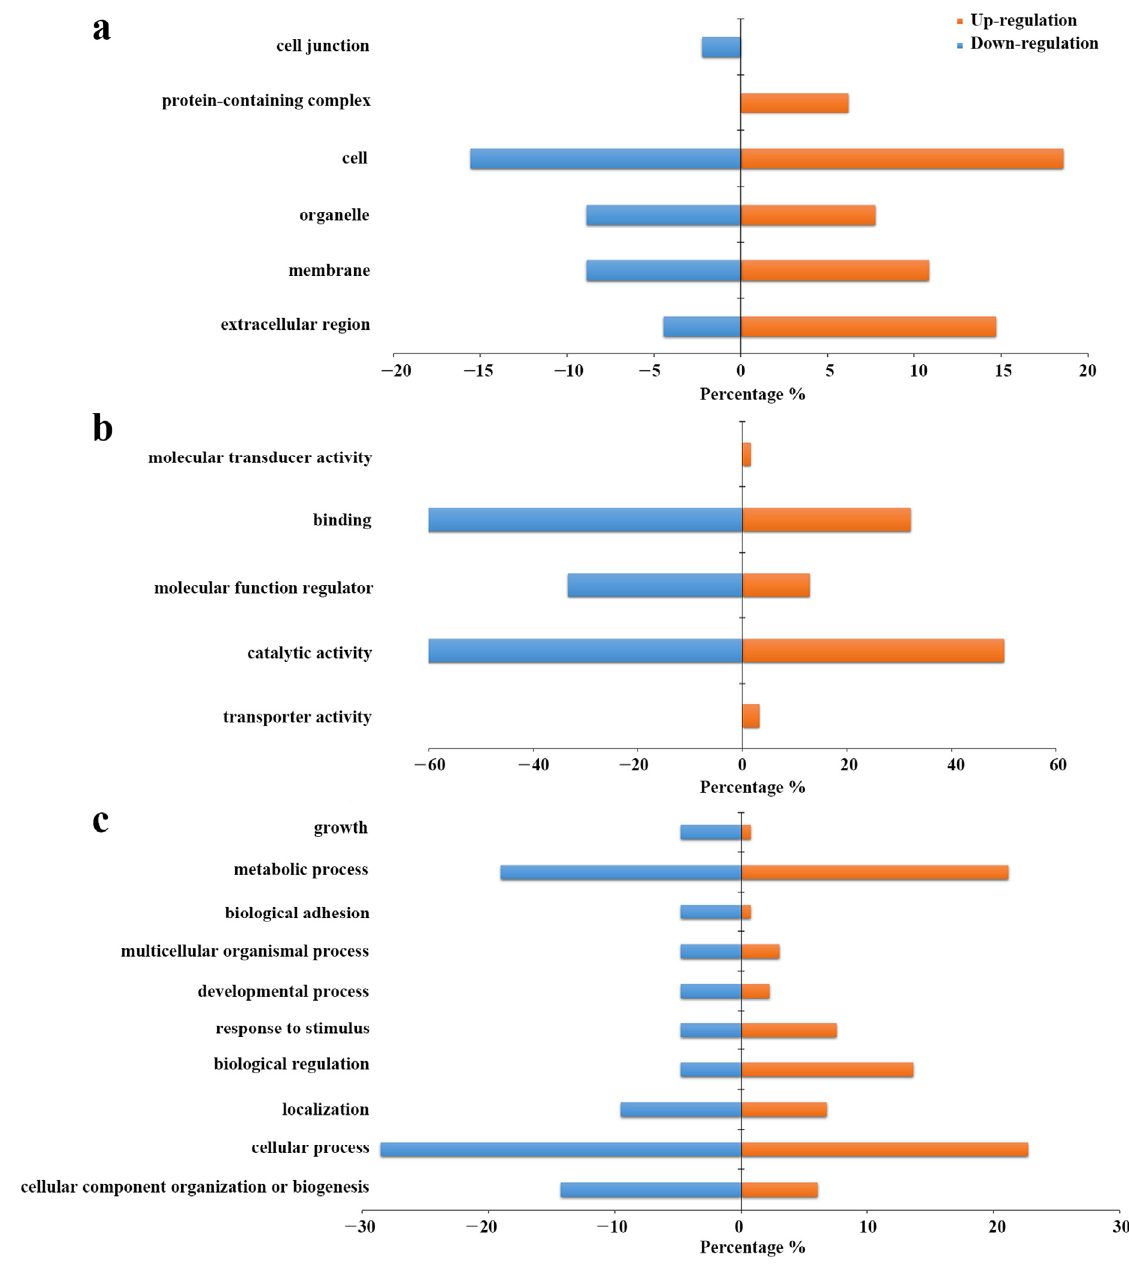
Figure 7. Gene ontology analysis of the intact N-glycoproteins corresponding to the differentially expressed intact N-glycopeptides in HCC relative to NC. ( a ) Cellular component. ( b ) Molecular function. ( c ) Biological process.